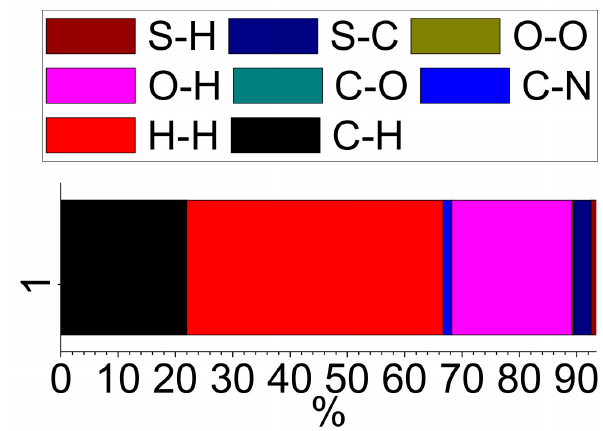
Figure 4. Two-dimensional (2D)-fingerprint plot of 1 showing ( a ) complete Hirshfeld surface; ( b ) O-H ... O short contacts.